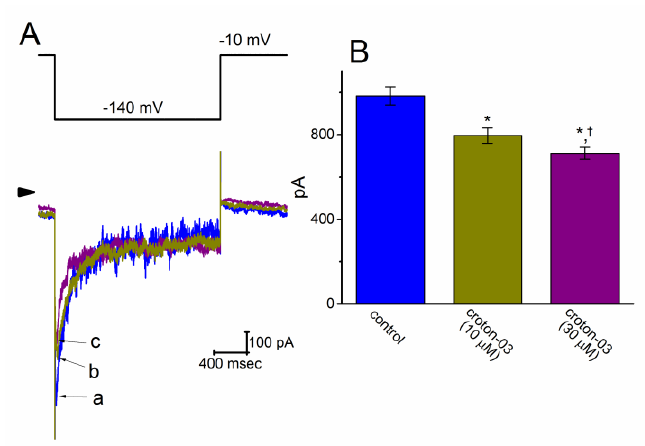
Figure 8. E ff ect of croton-03 on I K(erg) amplitude in INS-1 cells. In these experiments, we bathed in Ca 2 + -free, high-K + solution and, during the measurements, we filled the pipette by using K + -containing solution. ( A ) Representative I K(erg) traces elicited in response to 1-sec step hyperpolarization from − 10 to − 140 mV (as indicated in the upper part). The current trace labeled a is control, and those labeled b or c were obtained in the presence of 10 or 30 µ M croton-03, respectively. Arrowhead indicates the zero current level and calibration mark shown in the right lower side applies all current traces. ( B ) Summary bar graph of croton-03 e ff ects on the amplitude of deactivating I K(erg) elicited by membrane hyperpolarization (mean ± SEM; n = 8 for each bar). Current amplitude was taken at the beginning of each hyperpolarizing pulse. * Significantly di ff erent from control ( p < 0.05) and † significantly di ff erent from croton-03 (10 µ M) alone group ( p < 0.05).